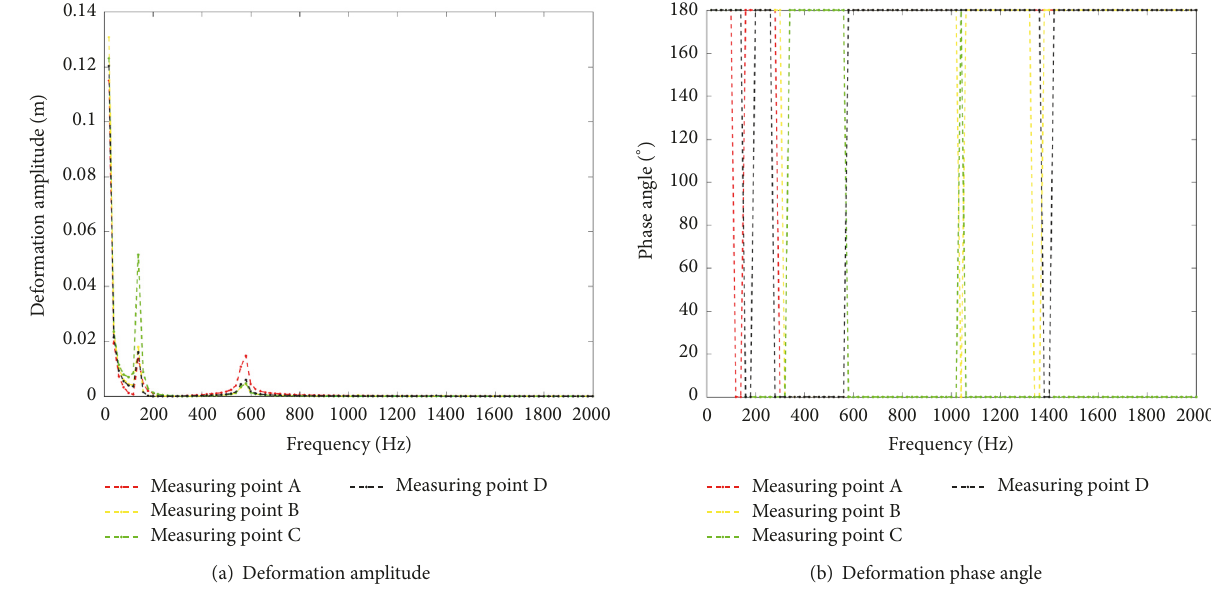
Figure 7: Harmonic responses of spiral bevel gear under different measuring